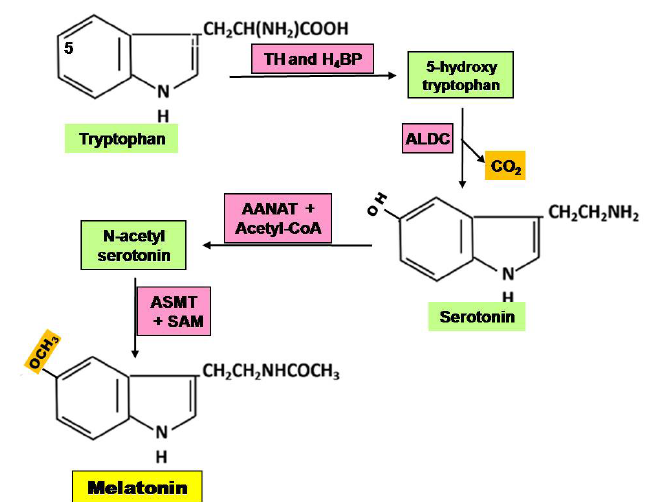
Figure 1. Steps of synthesis of melatonin in pineal gland. ALDC: aromatic L -amino acid decarboxylase; ASMT: acetylserotonin O -methyl transferase; H BP: tetra hydrobiopterin; SAM: S -adenosyl methionine; TH: tryptophan 4